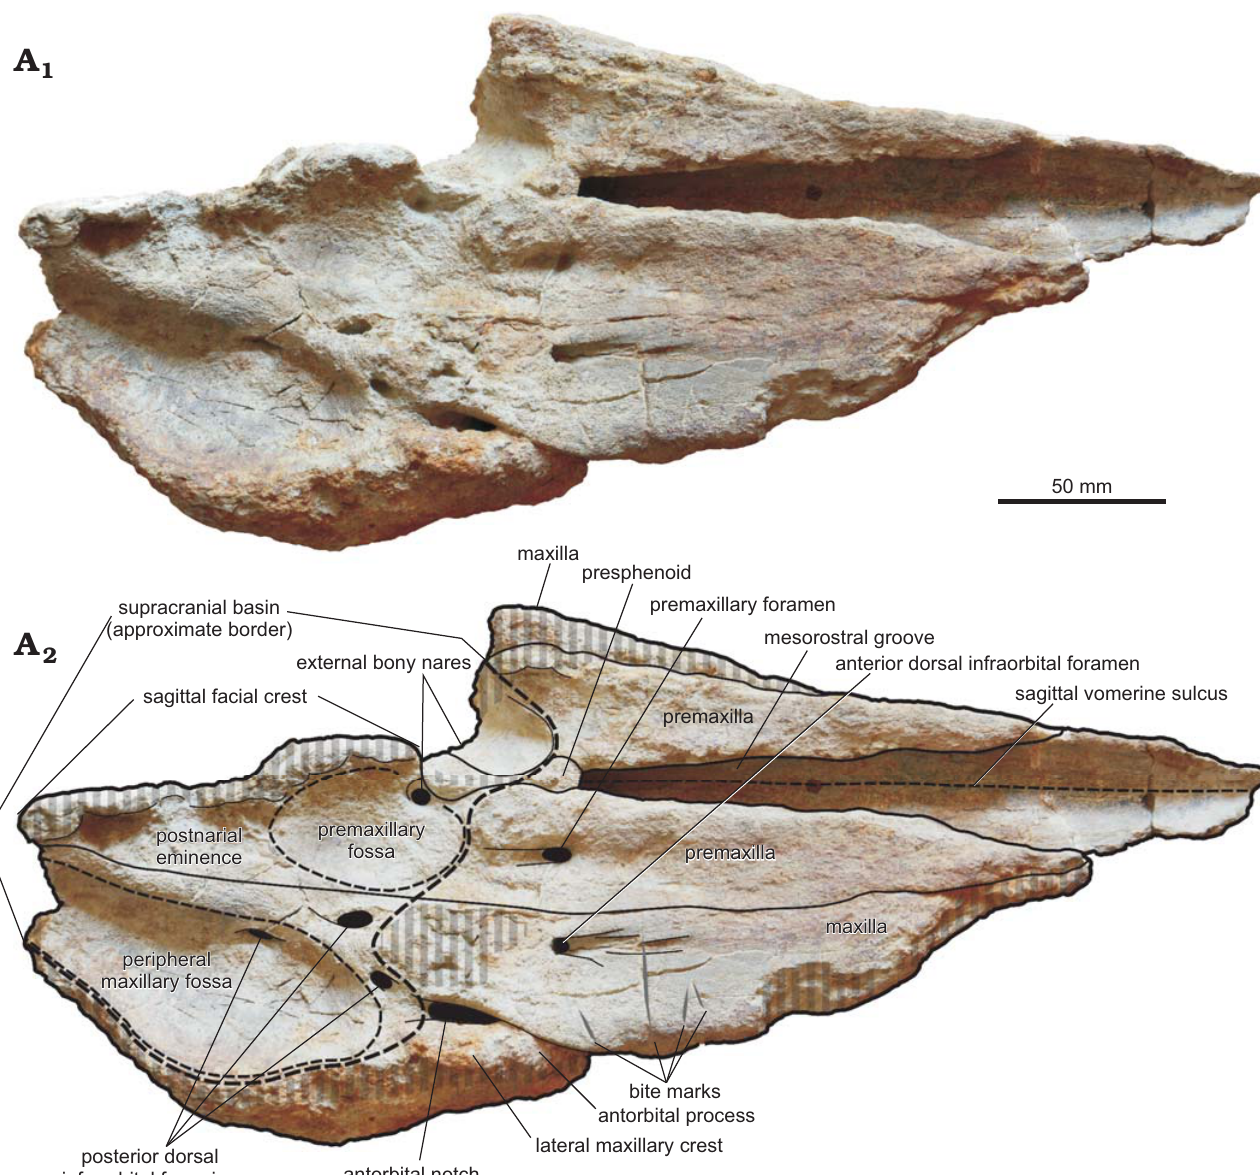
Fig. 2. Cranium, in dorsal view, of the kogiid sperm whale Pliokogia apenninica gen. et sp. nov. (MSNUP I-17603, holotype), from the lower Pliocene of Sant’Andrea Bagni (Northern Apennines, northern Italy). Photograph (A 1 ), explanatory drawing (A 2 ). The black areas correspond to openings in the skull. The grey vertical stripes denote abraded or broken areas. Dashed lines are for the sagittal vomerine sulcus and the approximate border of the supracranial basin, premaxillary fossa, and peripheral maxillary